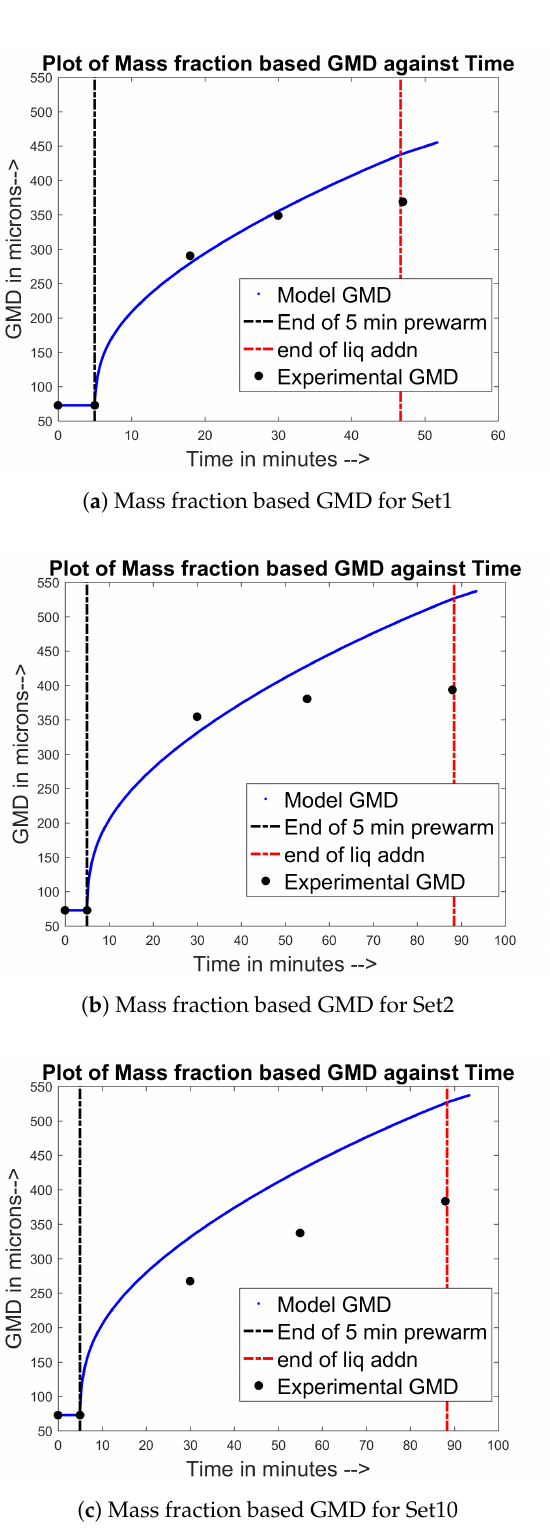
Figure 4. Experimental vs. model PSDs for Sets 1, 2 and 10 that were used for training the